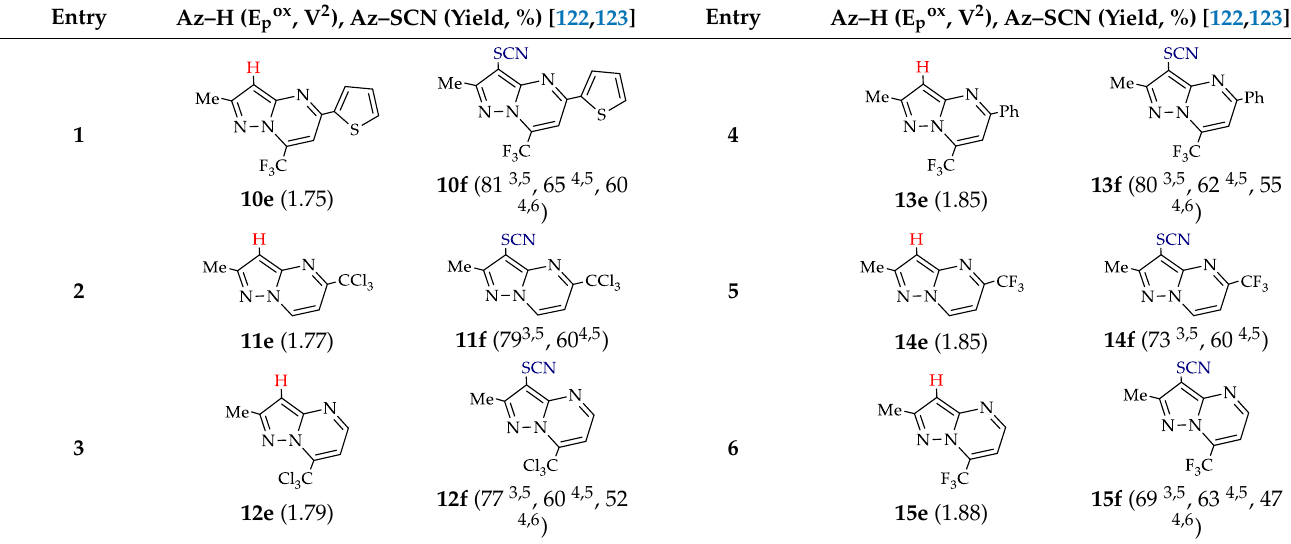
Table 5. C–H An thiocyanation of hardly oxidizable pyrazolo[1,5-a]pyrimidines ( Az-H) (approaches B and C) 1 . Table 5. C – H An thiocyanation of hardly oxidizable pyrazolo[1,5-a]pyrimidines ( Az‒H ) (approaches B and C) 1 . Table 5. C – H An thiocyanation of hardly oxidizable pyrazolo[1,5-a]pyrimidines ( Az‒H ) (approaches B and C) 1 . Table 5. C – H An thiocyanation of hardly oxidizable pyrazolo[1,5-a]pyrimidines ( Az‒H ) (approaches B and C) 1 . Table 5. C – H An thiocyanation of hardly oxidizable pyrazolo[1,5-a]pyrimidines ( Az‒H ) (approaches B and C) 1 . Table 5. C – H An thiocyanation of hardly oxidizable pyrazolo[1,5-a]pyrimidines ( Az‒H ) (approaches B and C) 1 . Table 5. C – H An thiocyanation of hardly oxidizable pyrazolo[1,5-a]pyrimidines ( Az‒H ) (approaches B and C) 1 . Table 5. C – H An thiocyanation of hardly oxidizable pyrazolo[1,5-a]pyrimidines ( Az‒H ) (approaches B and C) 1 . Table 5. C – H An thiocyanation of hardly oxidizable pyrazolo[1,5-a]pyrimidines ( Az‒H ) (approaches B and C) 1 . Table 5. C – H An thiocyanation of hardly oxidizable pyrazolo[1,5-a]pyrimidines ( Az‒H ) (approaches B and C) 1 . Table 5. C – H An thiocyanation of hardly oxidizable pyrazolo[1,5-a]pyrimidines ( Az‒H ) (approaches B and C) 1 . Entry Table 5. C – H An thiocyanation of hardly oxidizable pyrazolo[1,5-a]pyrimidines ( Az‒H ) (approaches B and C) 1 . Table 5. C – H An thiocyanation of hardly oxidizable pyrazolo[1,5-a]pyrimidines ( Az‒H ) (approaches B and C) 1 . Entry Entry Entry Entry Entry Entry Entry